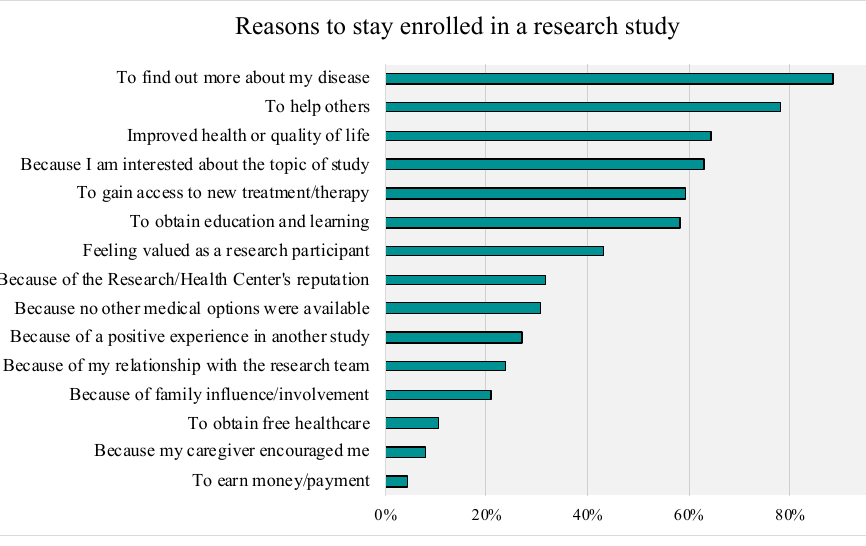
Figure 5. Rankings of Reasons for Staying Enrolled in a Research Study. Top Box Responses (“Very Important”) are Presented.